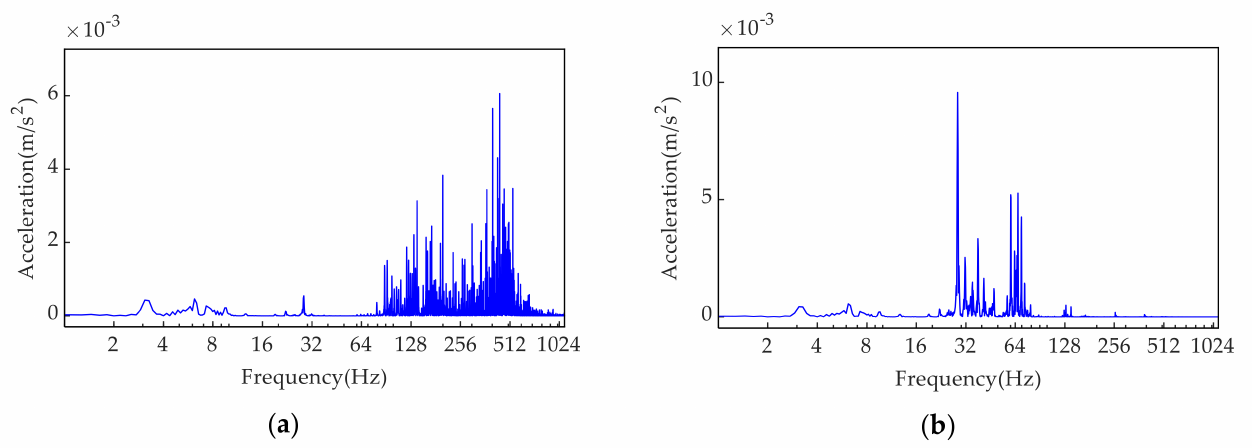
Figure 19. Frequency distribution of the vertical acceleration of the bridge under: ( a ) track short wave irregularity; ( b ) track medium-long wave